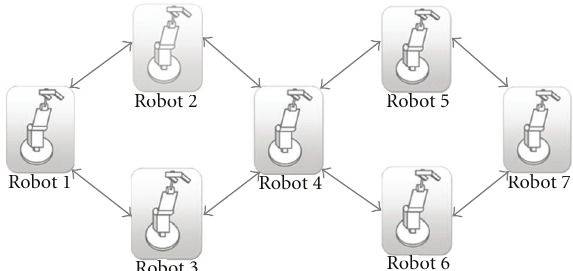
Figure 1: Multirobot system under mutual synchronization